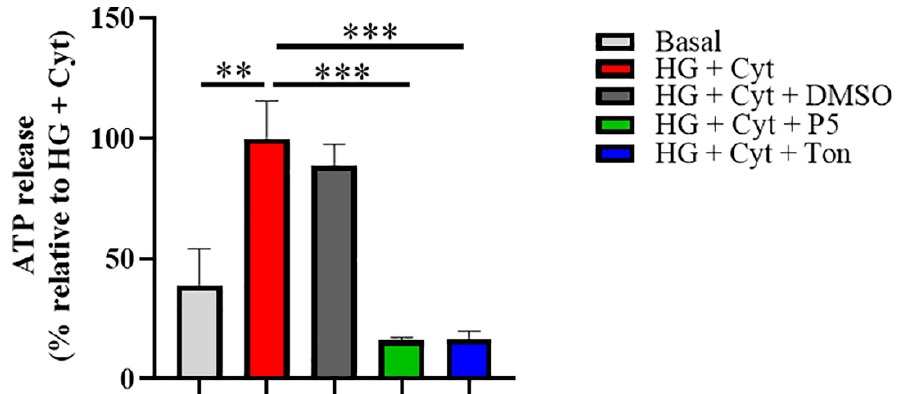
Figure 1. Effect of tonabersat and Peptide5 treatment on hyperglycemia and inflammatory cytokines (HG + Cyt)-induced ATP release. HG + Cyt induced a significant increase in ATP release compared to the untreated group ( p = 0.0053). Both tonabersat (HG + Cyt + Ton; p = 0.0009) and Peptide5 (HG + Cyt + P5; p = 0.0003) treatment significantly decreased ATP release to below basal levels (not significantly different). DMSO treatment (HG + Cyt + DMSO) did not induce or inhibit ATP levels. Data are presented as mean + SEM. Statistical analysis was carried out using one-way ANOVA with Dunnett’s multiple comparisons test. ** p ≤ 0.01; *** p ≤ 0.001, n = 3.